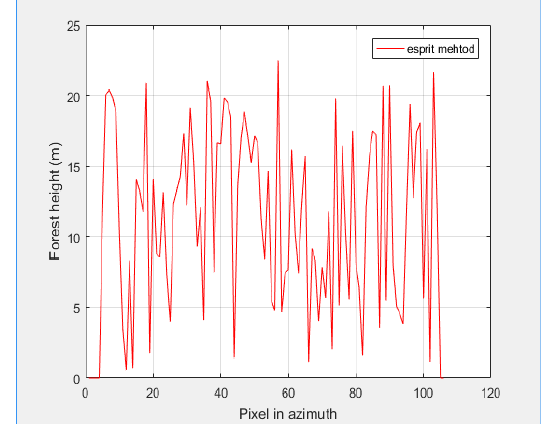
Figure 5. Height estimation result of ESPRIT method